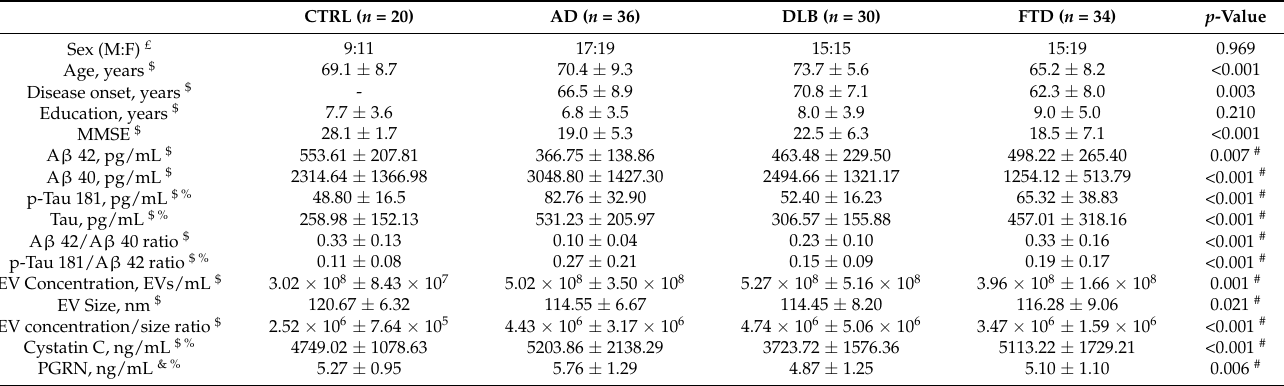
Table 1. Clinical, demographic, and biological variables of patients and